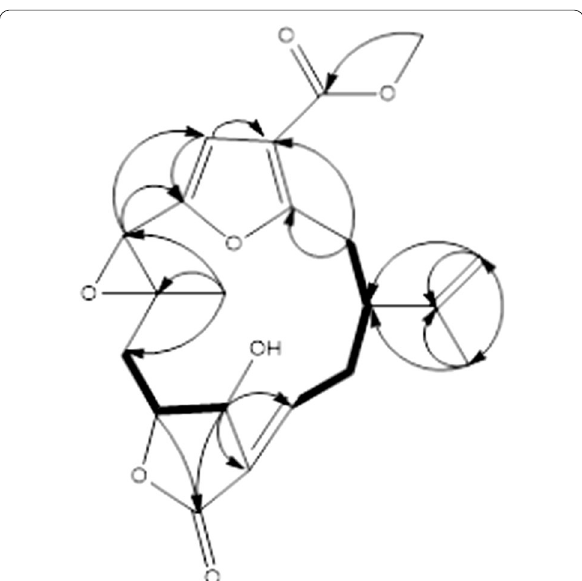
Fig. 2 1 H– 1 H COSY (bold lines) and selective HMBC (arrows) of compound